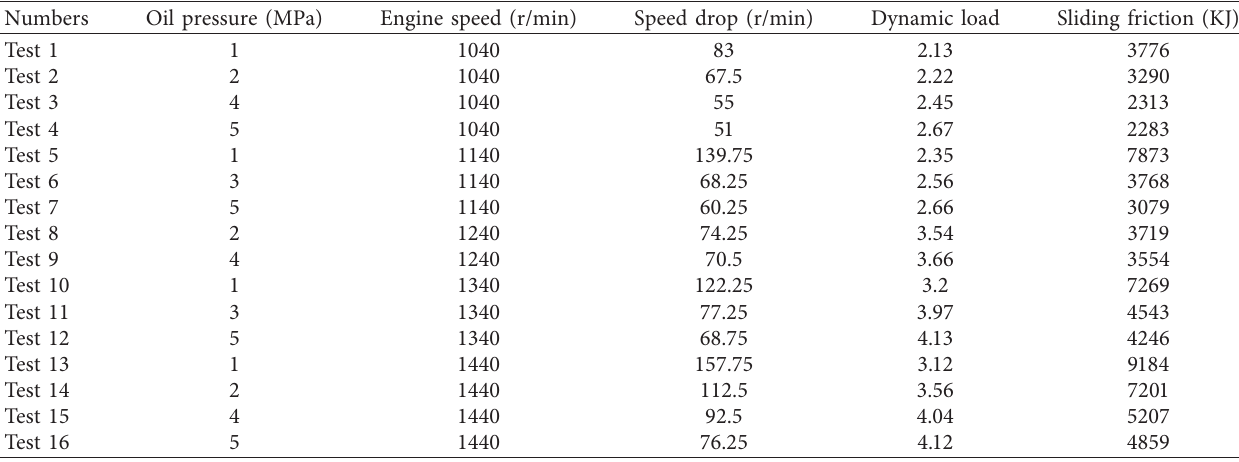
Table 9: Table of 16 groups of test